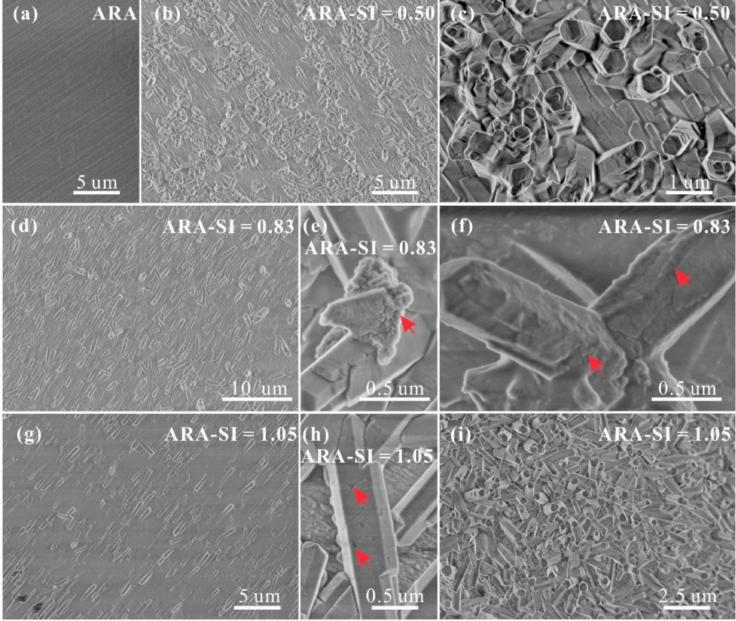
Figure 6. SEM images of ( a ) the polished aragonite (110) surface, and polished aragonite (110) surfaces after growing in solutions with Mg 2 + / Ca 2 + = 0 and ( b , c ) SI calcite = 0.50; ( d – f ) SI calcite = 0.83; ( g – i ) SI calcite =